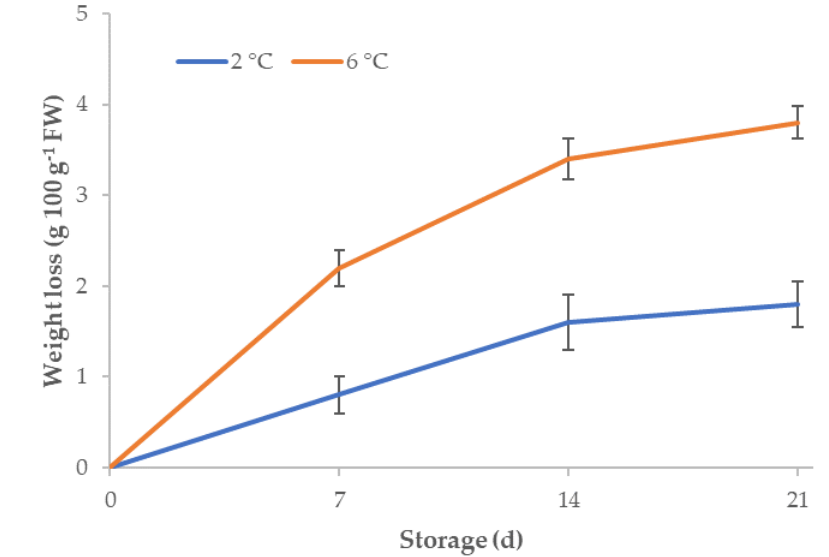
Figure 1. Influence of temperature and time of storage on weight loss of minimally processed borage leaves.